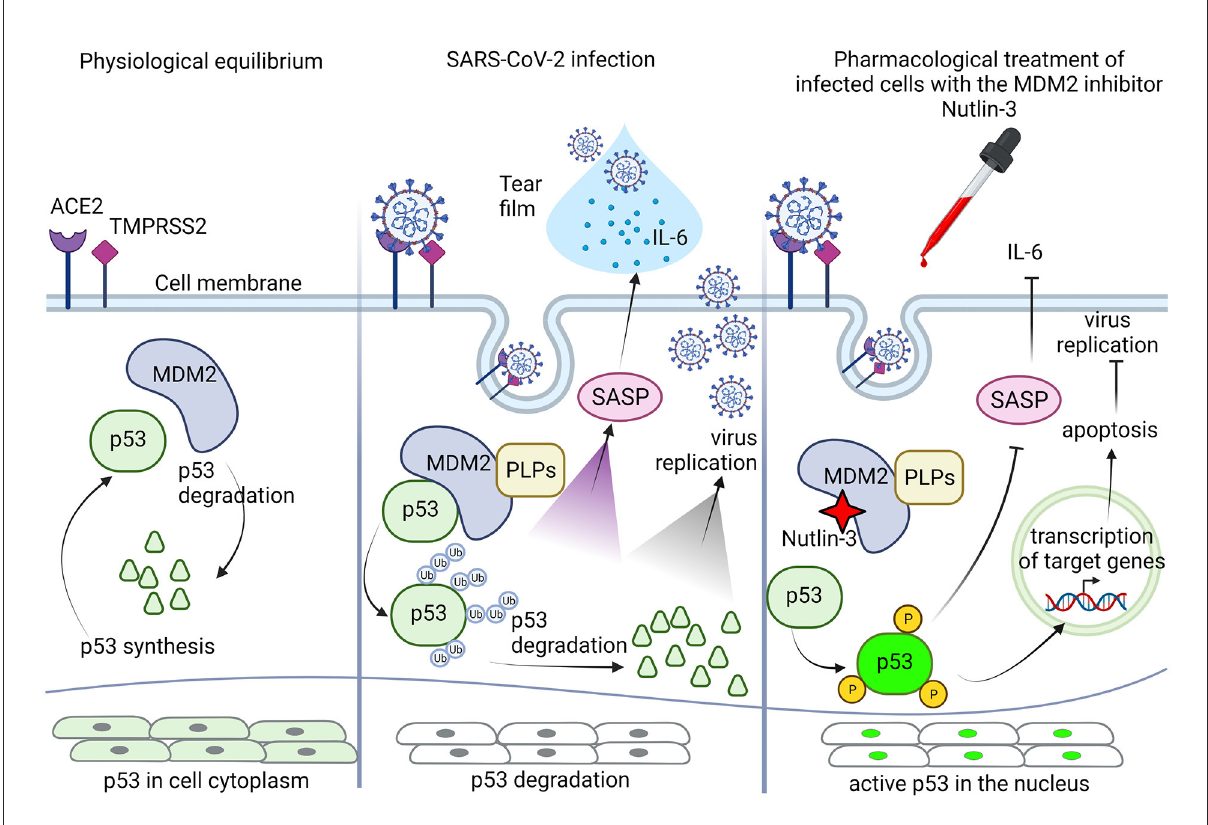
FIGURE1 Schematic representation of the potential role of p53 in corneal epithelial cells in response to pharmacological treatment with Nutlin-3. At physiological equilibrium, p53 life in corneal epithelial cells is controlled by its inhibitor MDM2, p53 synthesis and degradation are in balance, and p53 protein is present in the cytoplasm at high level in an inactive status. During SARS-CoV-2 infection, the cellular physiological equilibrium is altered by the papain-like proteases (PLPs) of the virus, that stabilizing MDM2 promote p53 ubiquitination and degradation. The p53 inhibition allows virus to take control of intracellular events, promoting its own replication and eventually leading to activation of senescence-associated secretory phenotype (SASP), with extracellular secretion of IL-6 and presence of both IL-6 and mature virions in the corneal tear-film. Following pharmacological treatment with the MDM2 inhibitor Nutlin-3, possible by eye drops, Nutlin-3 can interact with MDM2 and can free p53 from its inhibition, blocking its degradation. PLPs have a different binding site on MDM2, so Nutlin-3 can work efficiently. Once free, p53 can be activated by phosphorylation and then migrate to the nucleus to repristinate the control over several pathways, including down regulation of SASP with inhibition of IL-6 secretion, and apoptosis induction through transactivation of specific target genes, to finally moderate/ inhibit virus replication and propagation. Created with